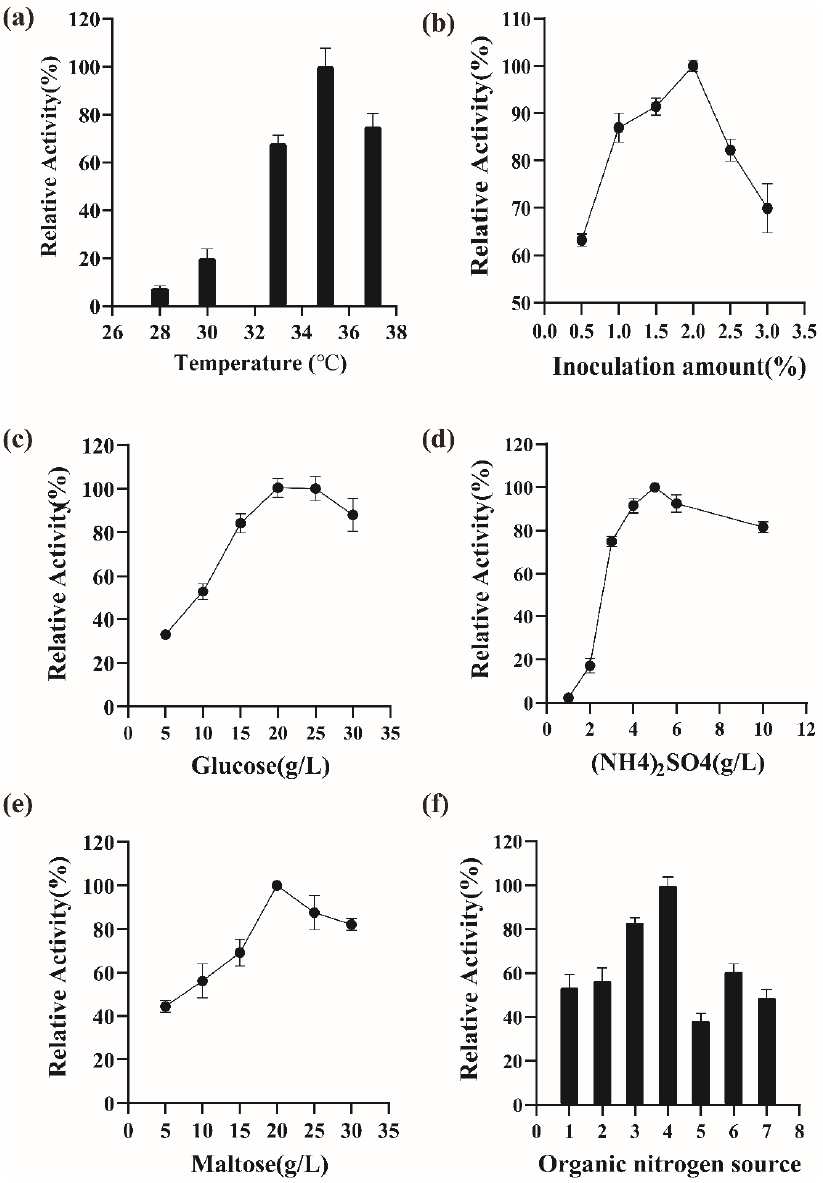
Figure 4. Optimization of culture conditions and medium composition of B. subtilis ‐ 5. ( a ) Temperature, ( b ) inoculum amount, ( c ) glucose, ( d ) NH 4 ) 2 SO 4 , ( e ) maltose, ( f ) organic nitrogen source. The